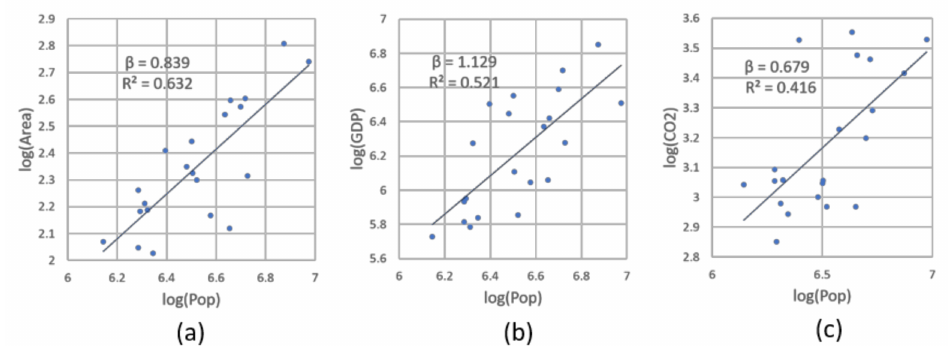
Figure 7. (Color online) Scaling relations and exponents for urban indicators reflected by NTL-based hotspots (Note: Panels ( a , c )show sub-linear scaling law for area/CO 2 emissions versus population; Panel ( b ) shows super-linear scaling law of GDP and population; all metrics for each city are calculated based on the extent of contained NTL-based